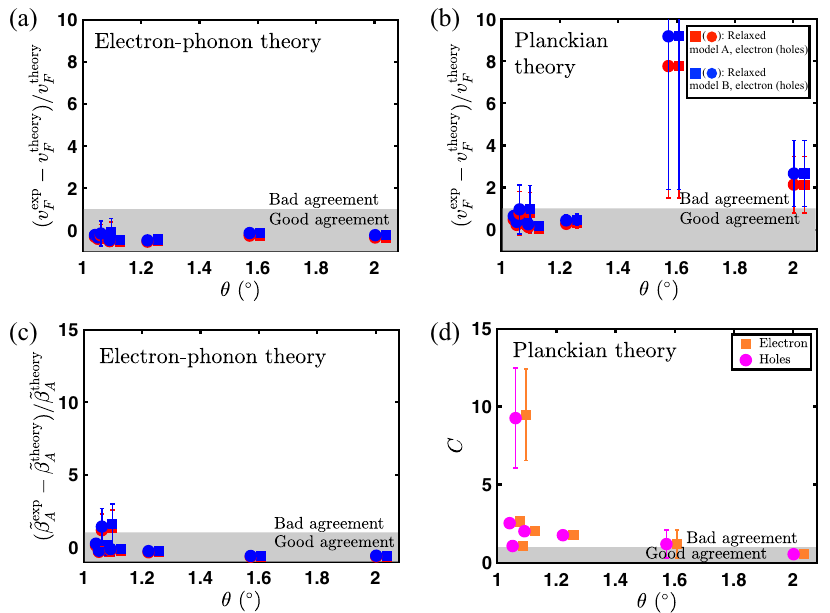
Fig. 5 The parameters obtained from fi t to refs. 2, 42, 62 (see Methods for details). We fi nd that the data agree much better with the expectations from the electron – phonon theory than the Planckian model. a Relative deviations of Fermi velocity as a function of twist angle obtained by fi tting the experimental resistivity to the electron – phonon theory ( b ) obtained by fi tting to the Planckian theory, c Relative deviations of the effective electron – phonon coupling constant ~ β A , and d Planckian strength C . The error bars represent 95% con fi dence interval of the parameters. The Planckian bound ( C ≤ 1) is violated for small twist angles rules out the Planckian model as the dominant transport mechanism in tBG.